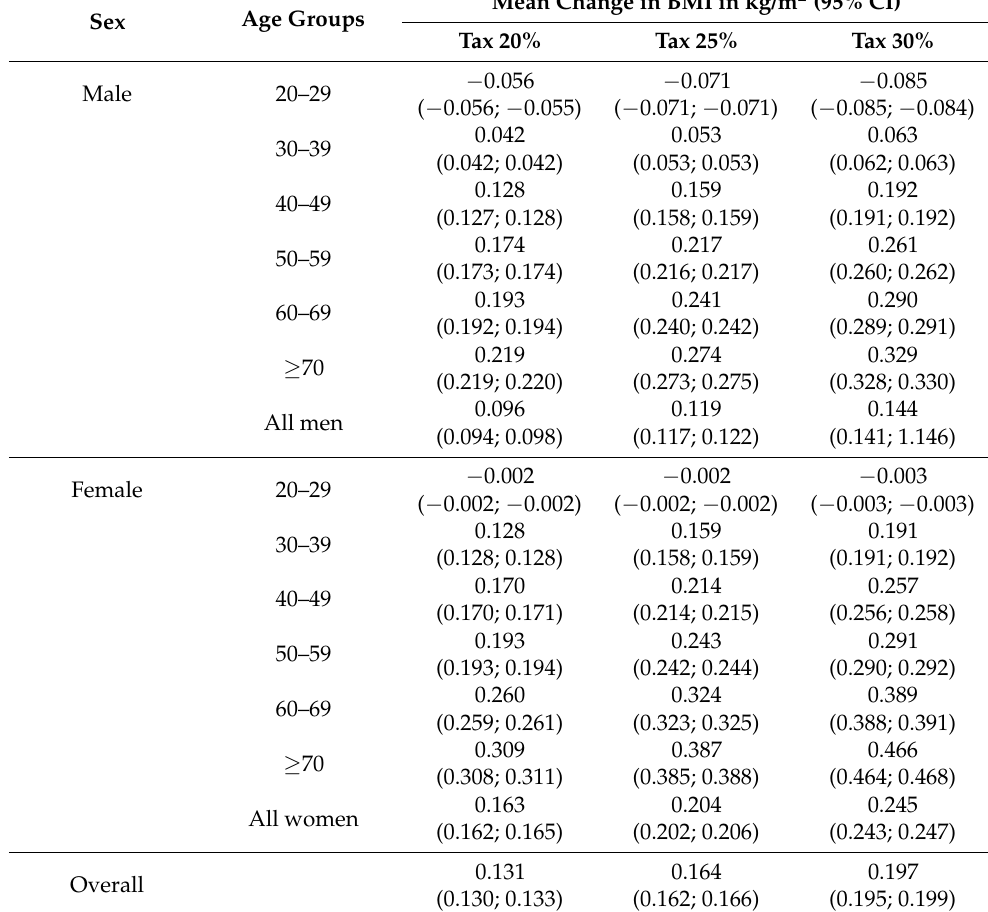
Table 2. Estimated mean change in BMI (kg/m 2 ) in the three taxation scenarios according to sex and age